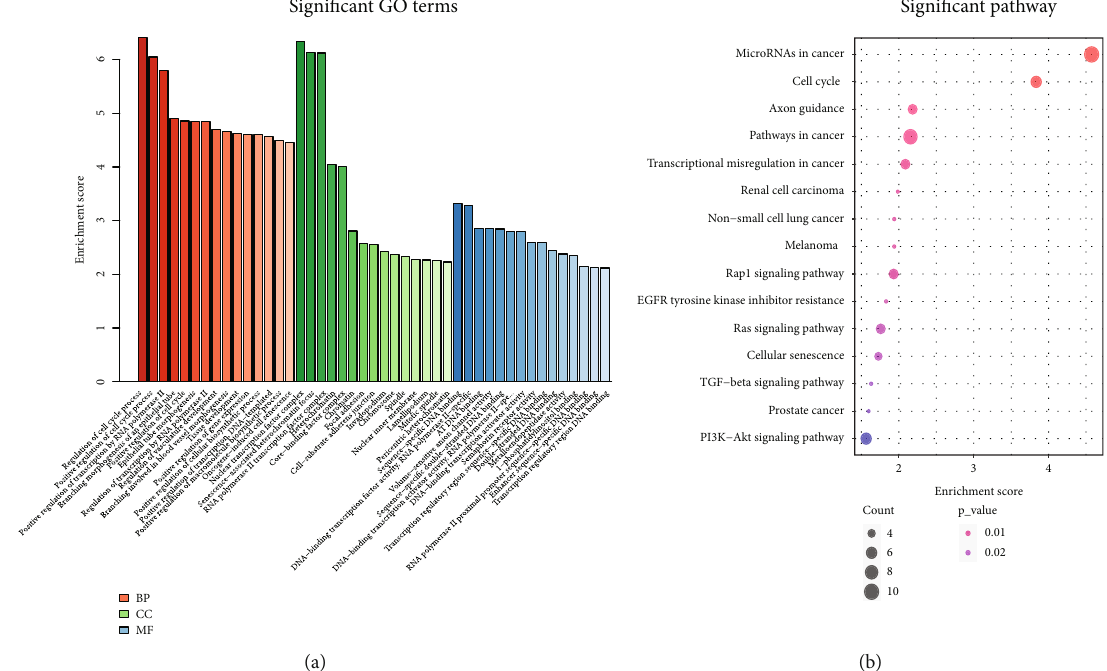
Figure 4: The DEmRNAs in the DEcircRNA-DEmiRNA-DEmRNA network were analyzed by GO annotation and KEGG pathway. (a) The top 15 GO terms enriched by DEmRNAs based on BP, CC, and MF categories. (b) Pathways signi fi cantly enriched by the DEmRNAs in the KEGG database. Red indicates small p value, and blue indicates large p value; the size of the bubbles indicates the degree of enrichment, and larger bubbles re fl ect larger gene